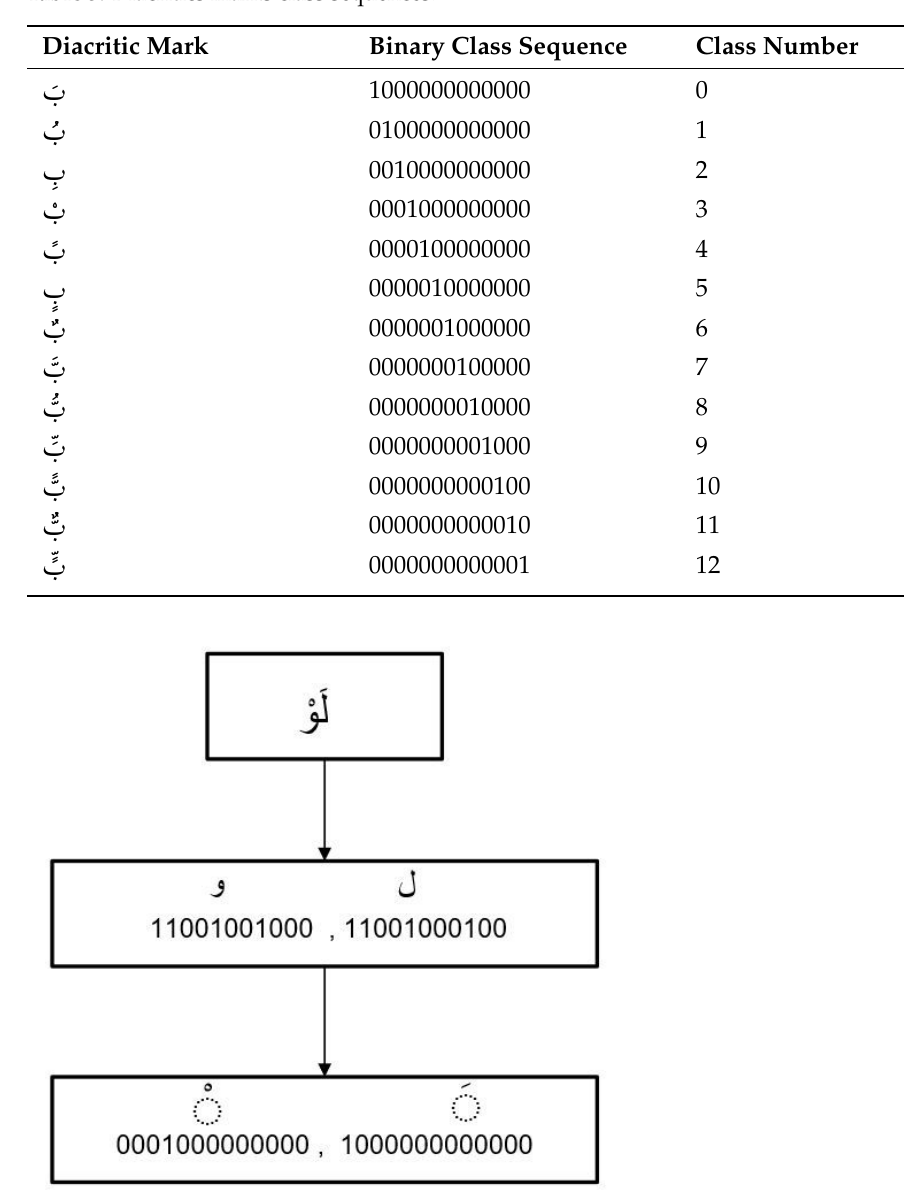
Figure 4. mapping